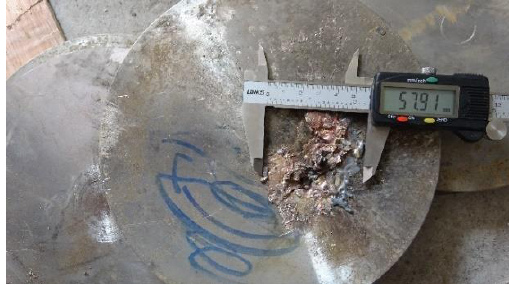
Figure 11. Penetration effect of residual jet.